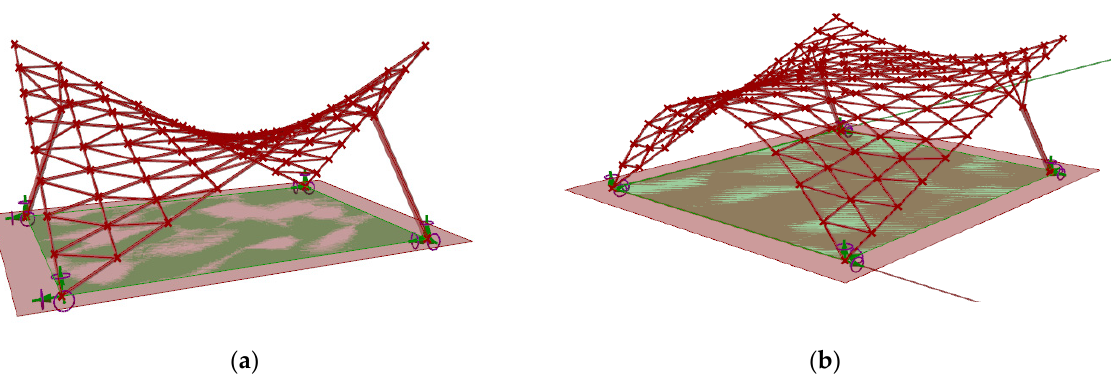
Figure 1. The view of the considered structures of: (a) hyperbolic paraboloid shape; ( b ) cylindroid shape. Both the hyperbolic paraboloid and the cylindroid are ruled surfaces composed of straight lines—the so-called rulings. Each surface can be defined by two directrices, which are lines, and a so-called director plane to which all rulings are parallel. However, the hyperbolic paraboloid roof surface can be established by two screw lines, whereas the cylindroid roof surface can be established by two curved lines included in various planes (Figure 2). In the presented study, the cylindroid was determined by two parabolas shaped in opposite directions and included in the parallel planes.